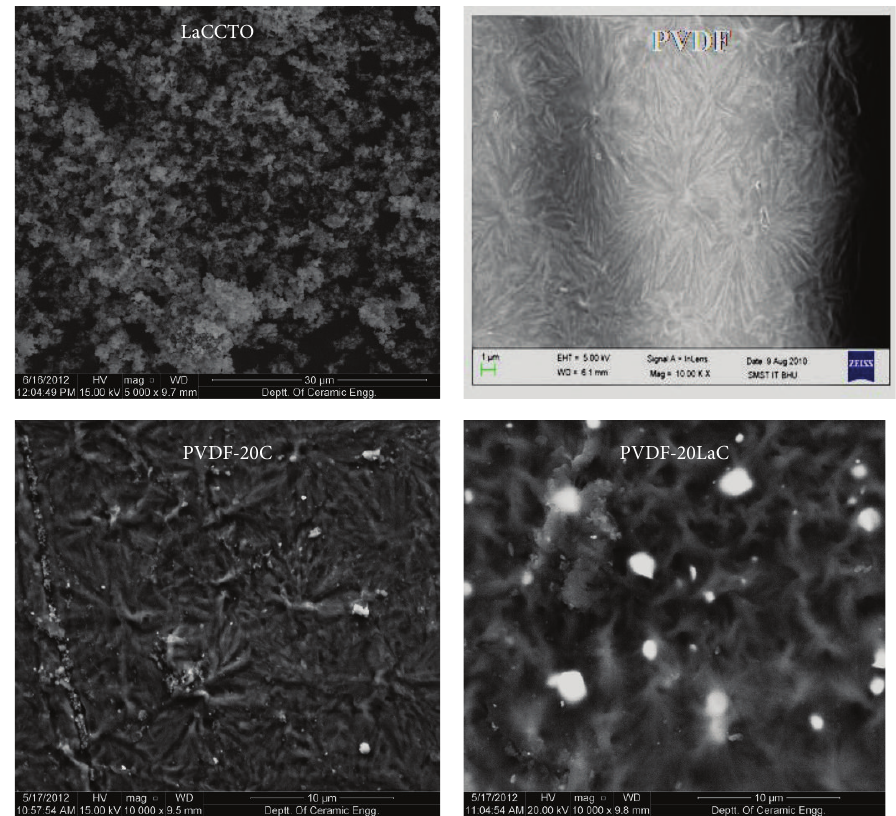
Figure 2: Scanning electron micrographs of LaCCTO, PVDF, PVDF-20C, and PVDF-20LaC composites.